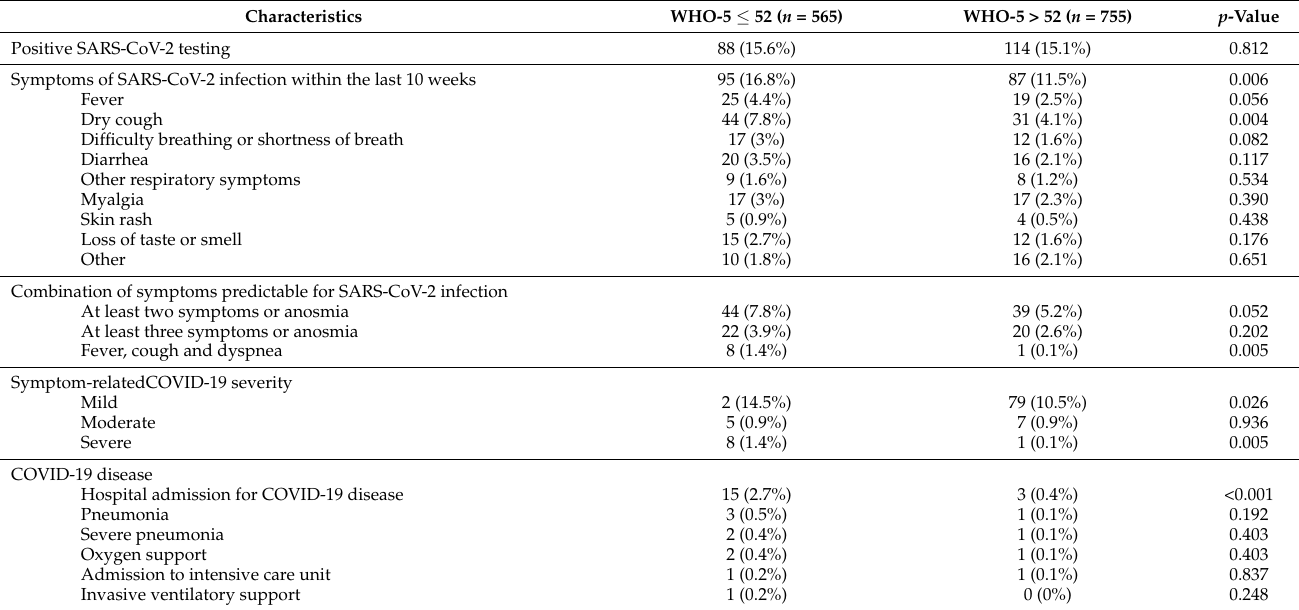
Table 5. Symptoms and diagnosis of SARS-CoV-2 infection and COVID-19 disease in the pandemic cohort based on the level of maternal WHO-5 well-being.